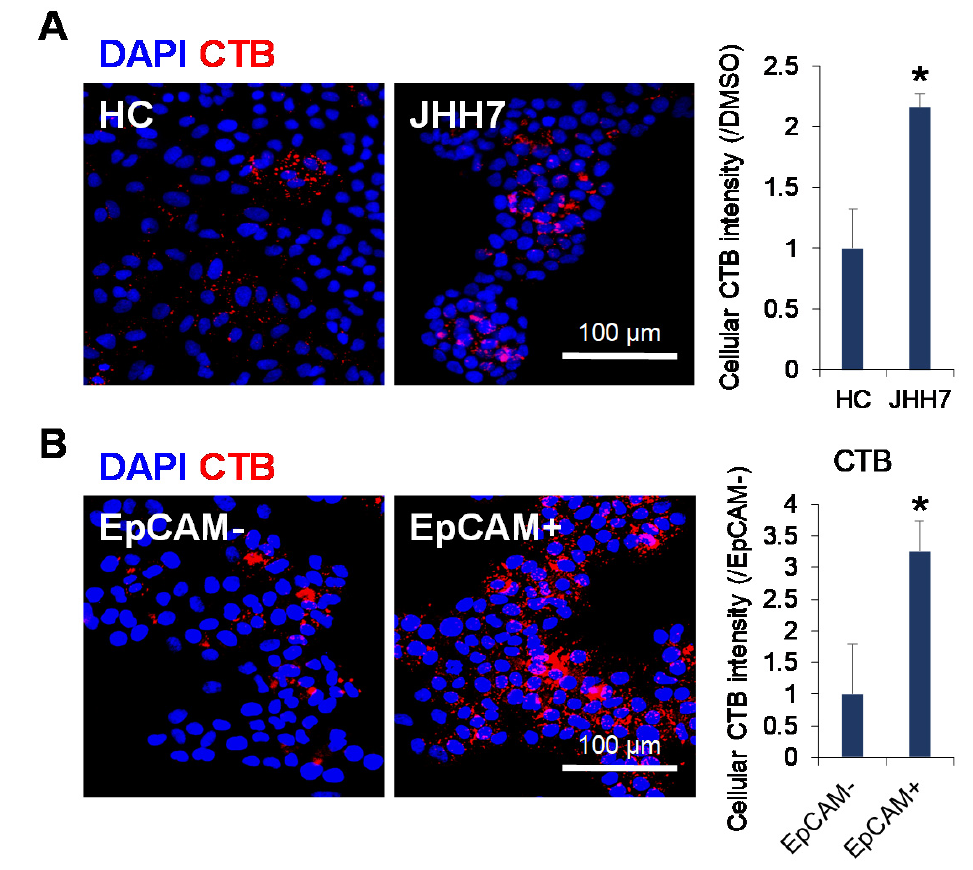
Figure 2. Enhanced ganglioside synthesis in human liver cancer stem-like cells. ( A ) Immunofluorescence staining of GM1 probe CTB (red) in normal hepatic cells HC and HCC cell line, JHH7 (left), and the relative fluorescent intensity of CTB (right). ( B ) Immunofluorescence staining of GM1 probe CTB (red) in sorted EpCAM-negative (EpCAM-) and EpCAM-positive (EpCAM+) HCC cell JHH7, and the relative fluorescent intensity of CTB (right). Scale bars, 100 µ m. Nuclei were stained with DAPI (blue). The data are presented as means ± SD. * p < 0.05 in Student’s t -test.